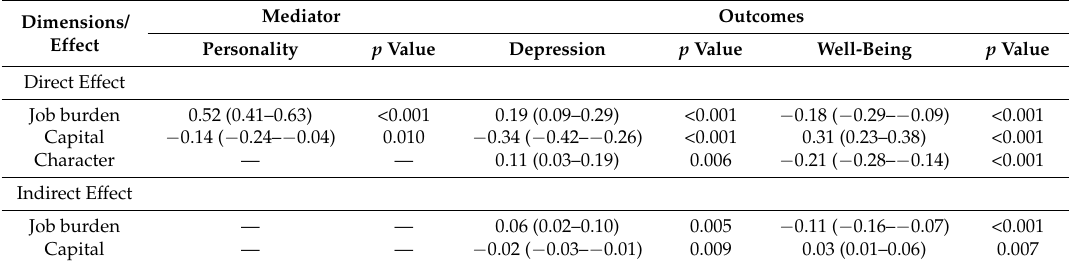
Table 4. Direct and indirect effects of the structural